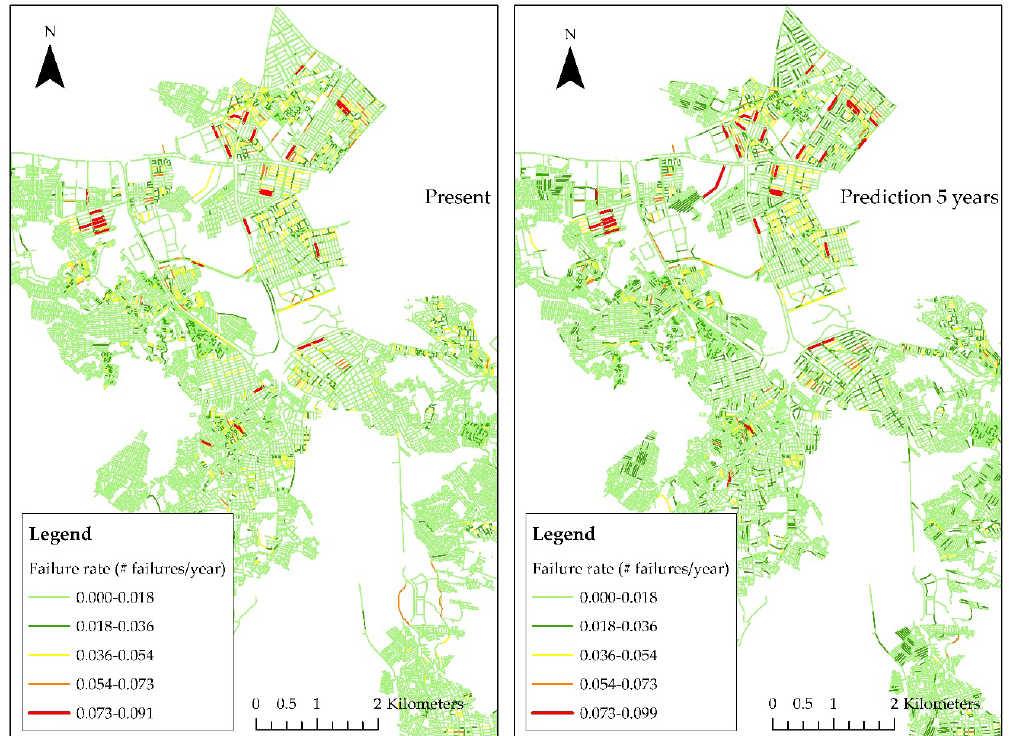
Figure 6. Failure rate prediction in asbestos-cement and PVC pipes.